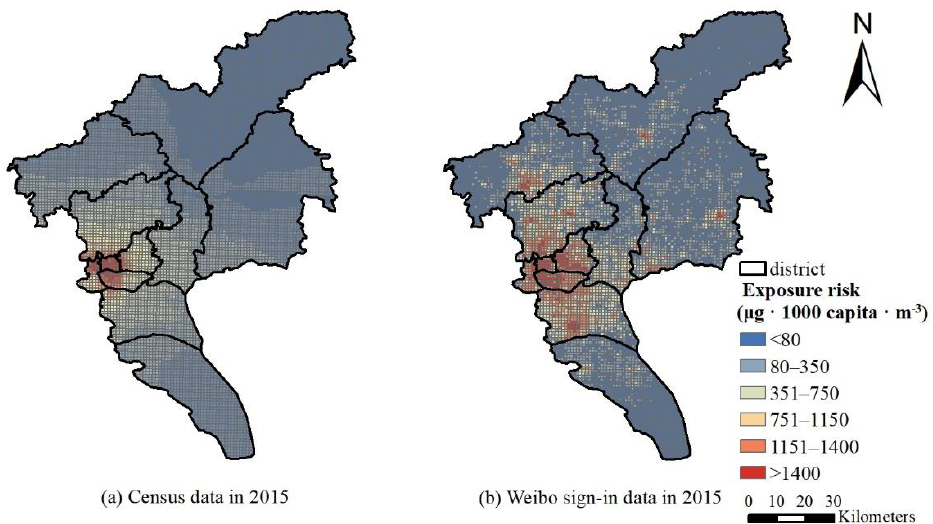
Figure 6. Comparison of average annual PM 2.5 population exposure risk in Guangzhou: ( a ) census data in 2015; ( b ) Weibo sign-in data in 2015.